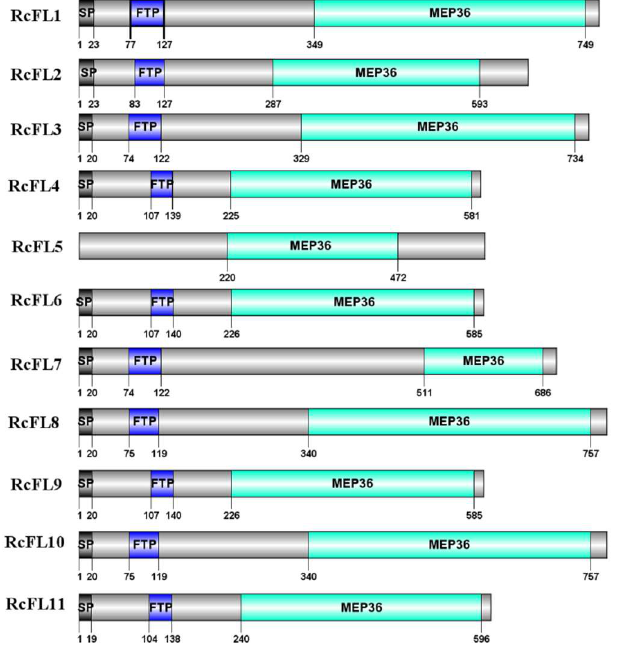
Figure 2. Predicted functional domains present in the MEP36 family metalloproteases of R. cerealis . SP: Signal peptide, FTP: Fungalysin/Thermolysin Propeptide Motif. Green: MEP36 domain.